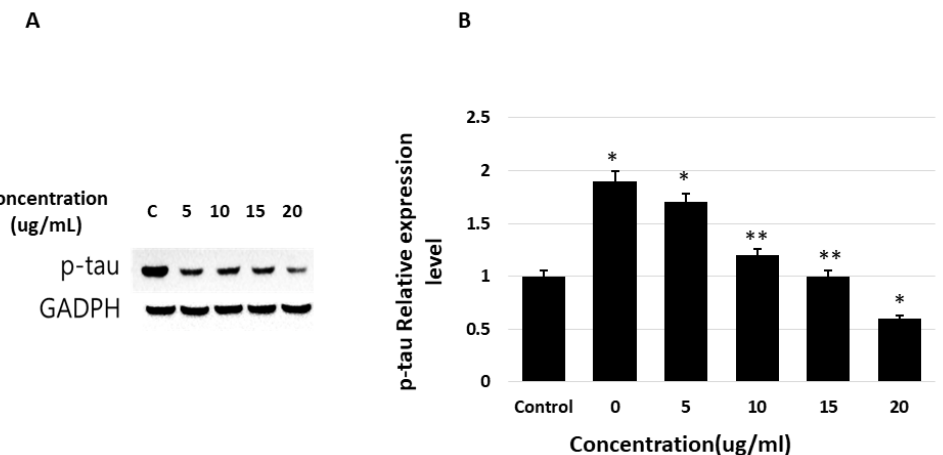
Figure 7. Reduction in the levels of A β peptides and p-tau after treatment with theasaponin (due to enhancement or reduction in the activities of various kinases and phosphatases), determined by ELISA. ( a ) A β quantification with ELISA after the treatment of cells with different concentrations of theasaponin E1. ( b ) p-tau quantification with ELISA after the treatment of cells with different concentrations of theasaponin E1. Data were analyzed using one-way ANOVA ( n = 3) and expressed as mean ± SEM. Data are statistically significant at p < 0.05 (* p < 0.05; ** p < 0.01 to the control group).